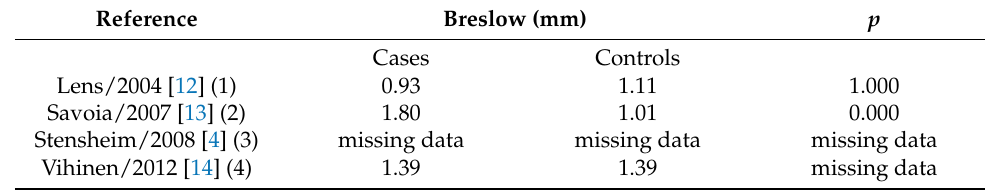
Table 2. Melanoma characteristics.